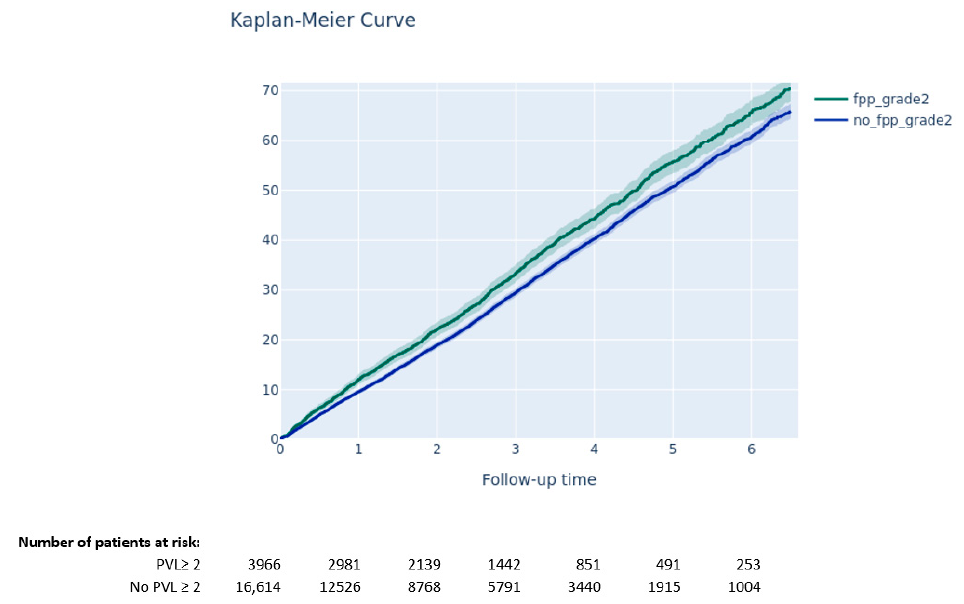
Figure 4. Survival according to the presence of grade ≥ 2 paravalvular leak (Kaplan–Meier curve).